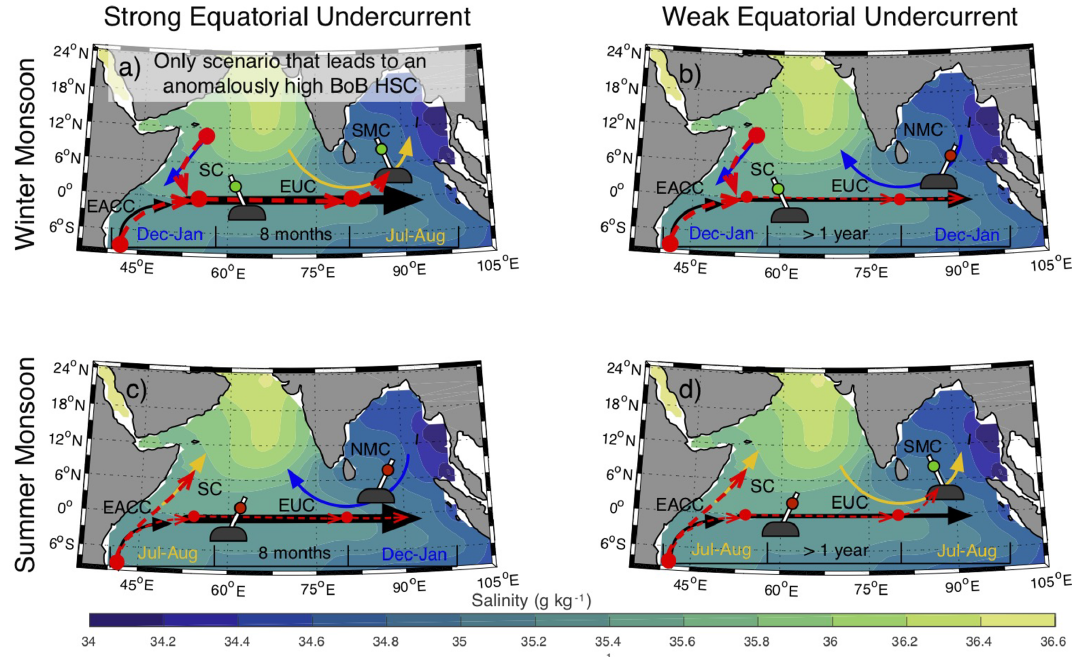
Figure 19. Seasonal circulation pathways in the northern Indian Ocean, or the railroad switch schematic, on subsurface (90m) salinity climatology (psu; shaded) from the Argo optimally interpolated product for the four Equatorial Undercurrent scenarios: (a, b) winter monsoon and strong (weak) Equatorial Undercurrent and (c, d) summer monsoon and strong (weak) Equatorial Undercurrent. Dashed red arrows indicate high-salinity advection. BoB stands for Bay of Bengal, HSC stands for high-salinity core, SMC stands for Southwest Monsoon Current, SC stands for Somali Current, EUC stands for Equatorial Undercurrent, EACC stands for East African Coastal Current. Figure taken from Sanchez-Franks et al.